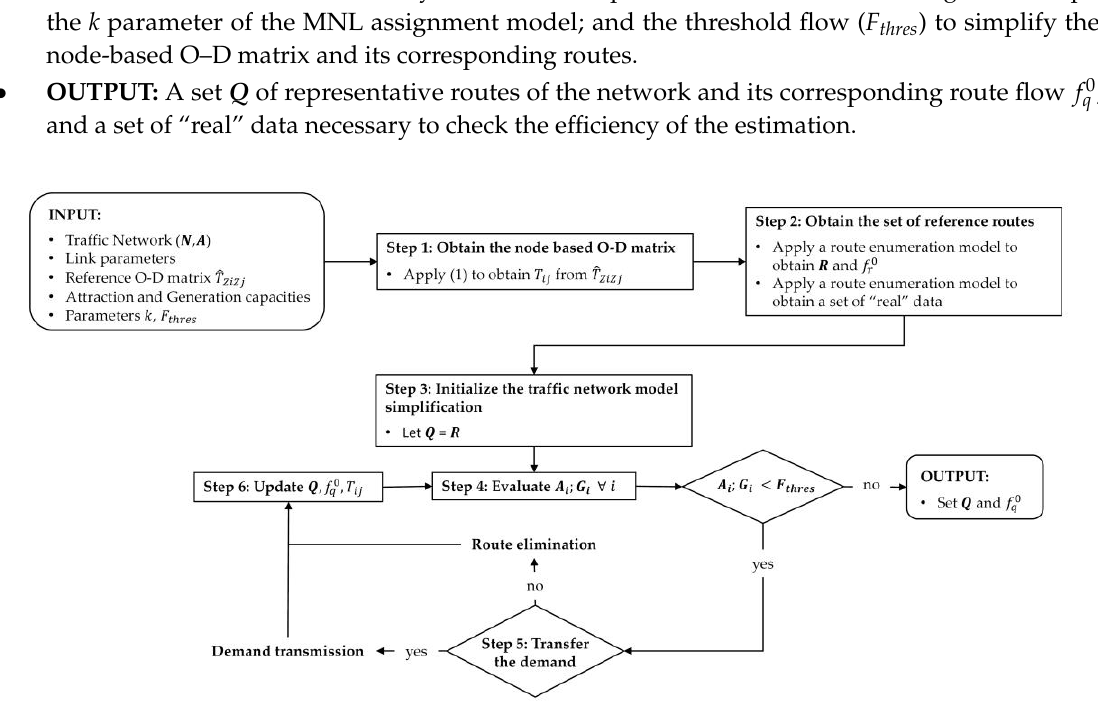
Figure 8. Flowchart of the algorithm defined for the traffic network modelling.